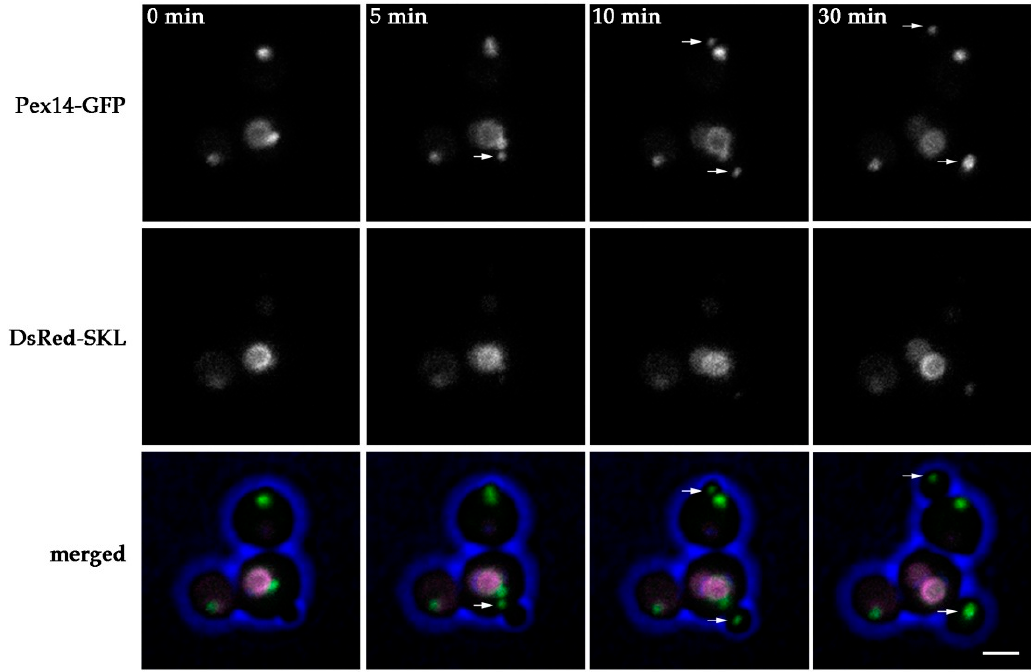
Figure 2. Peroxisome fission and inheritance in H. polymorpha pex11 . Stills from a CLSM video (Supplementary Data S1) representing budding pex11 cells producing Pex14-GFP and DsRed-SKL. Blue represents cell edges. Arrows point to Pex14-GFP containing spots that separate from a mother organelle during yeast budding and are transferred to a forming daughter cell. Images were acquired with 5 min time intervals. Scale bar represents 2 µm.